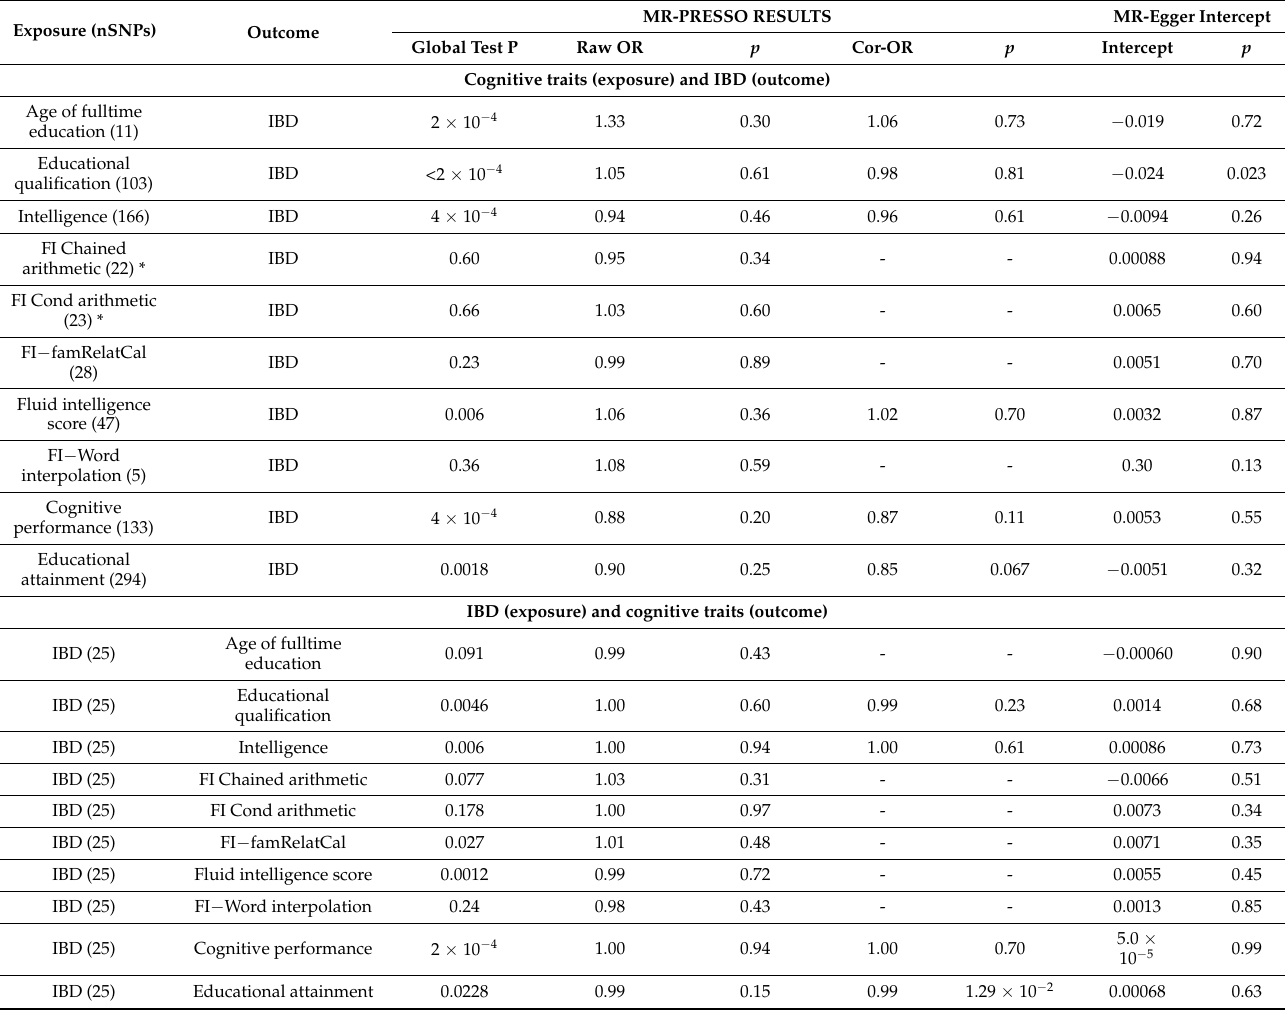
Table 6. Results of bidirectional MR-PRESSO analysis for IBD and cognitive